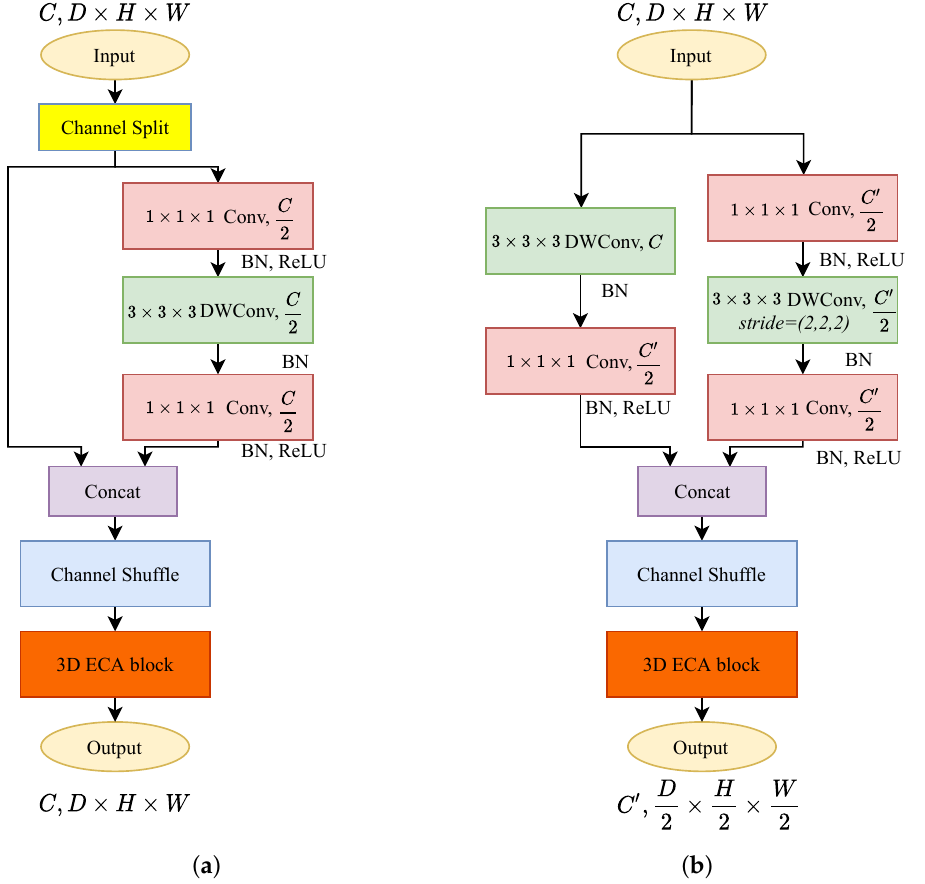
Figure 5. We build the 3D ECA blocks after the channel shuffle operations on 3D ShuffleNet V2. ( a ) 3D ECA-ShuffleNetV2 with stride = 1. ( b ) 3D ECA-ShuffleNetV2 with stride =